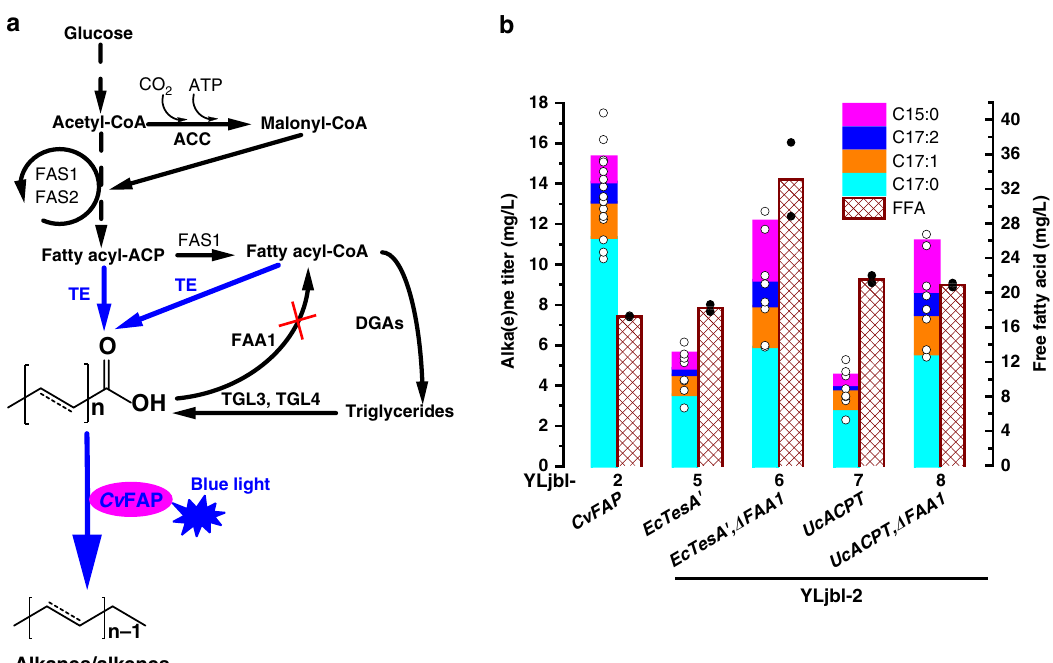
Fig. 1 The effect of expression of thioesterases on alka(e)ne production. a Metabolic pathways for alka(e)ne production employing the fatty acid photodecarboxylase according to previous literature that free fatty acids are the precursors of alka(e)nes (the revised pathway is shown in Fig. 2). Black arrows represent native pathways while blue arrows indicate heterologous pathways. TE, acyl-CoA/acyl-ACP thioesterases; TGL3 and TGL4, intracellular lipases from Y. lipolytica ; FAA1, acyl-CoA synthase, ACC, acetyl-CoA carboxylase, FAS1 and FAS2, fatty acid synthase 1 and 2, DGAs, diacylglycerol transferases. b Alka(e)ne production is observed by expressing photodecarboxylase in a wild-type strain. Expression of thioesterases ( Ec TesA ′ and Uc ACPT) and knockout of FAA1 did not enhance alka(e)ne production but decreased, although free fatty acid titers were increased. Fermentations were performed in 50 mL conical shake fl asks with a working volume of 13 mL and an initial OD 600 of 0.1 for 3 days in the dark followed by 3 days in blue light generated by light source 1 (Supplementary Fig. 16). Fermentation medium was composed of 20 g/L glucose, 6.9 g/L yeast nitrogen base (without amino acids), and 1 g/L yeast extract. Data represent mean value, n = 2 biologically independent samples. Source data underlying Fig. 1b are provided as a Source Data fi